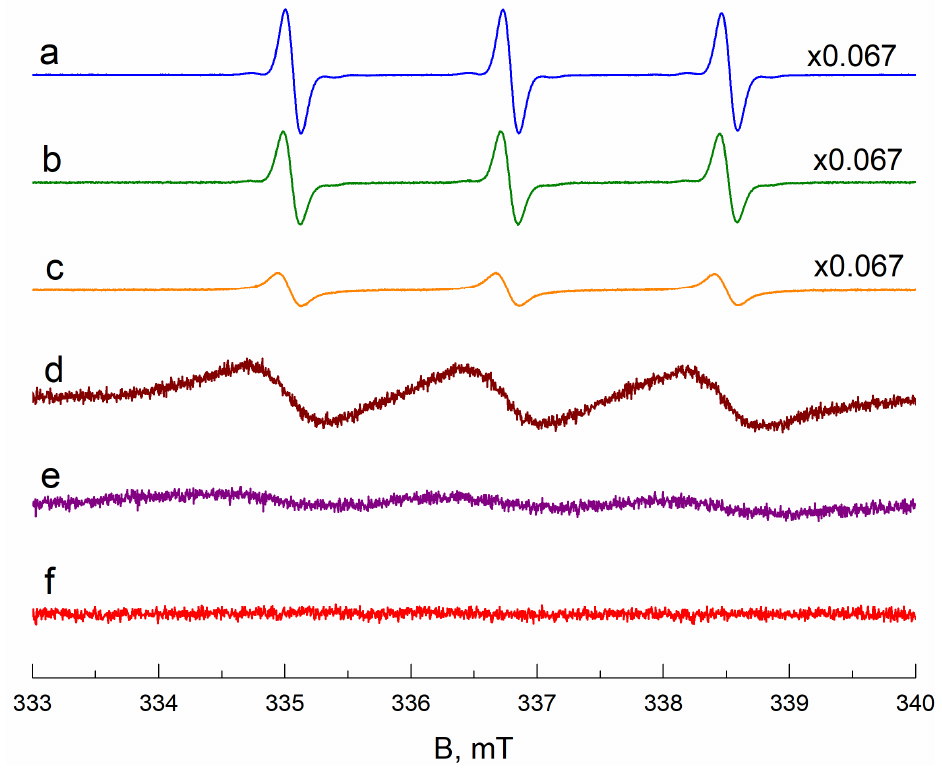
Figure A5. EPR spectra of TEMPO radical in water in the presence of Cu(II) ions: ( a )—[Cu(II)] = 0,